Question: Provide a one-line summary of what is displayed.
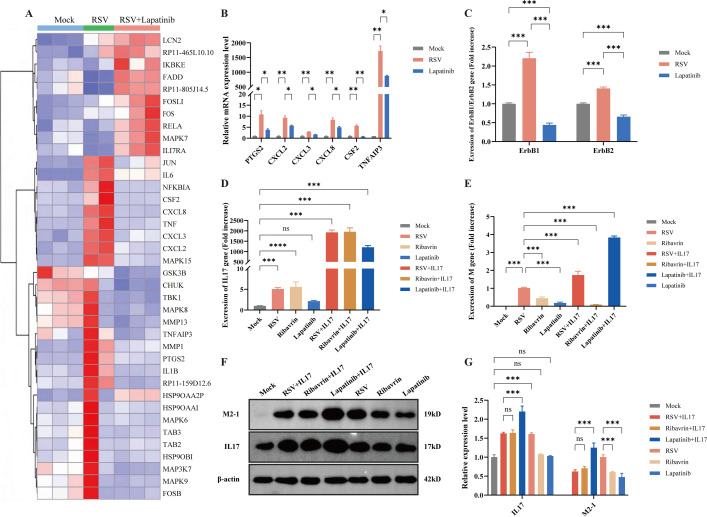
Answer: IL-17 signaling pathway-related genes and detection of lapatinib targets of action. ( A ) Heatmap of genes involved in the IL-17 signaling pathway. ( B ) Expression of representative genes of the IL-17 signaling pathway. ( C ) Gene expression of ErbB1 and ErbB2. ( D ) Changes in IL-17A expression after RSV infection and drug treatment. ( E ) Overexpression of IL-17A and its effect on viral replication after drug treatment. ( F ) Differences in the molecular expression of the RSV M2-1 and IL-17 proteins after drug treatment. ( G ) Gray value analysis results of F by ImageJ. Drug concentrations: 400 μM ribavirin; 3.125 μM lapatinib. Data represent the means ± SDs. * P < 0.05, ** P < 0.01, *** P < 0.001.